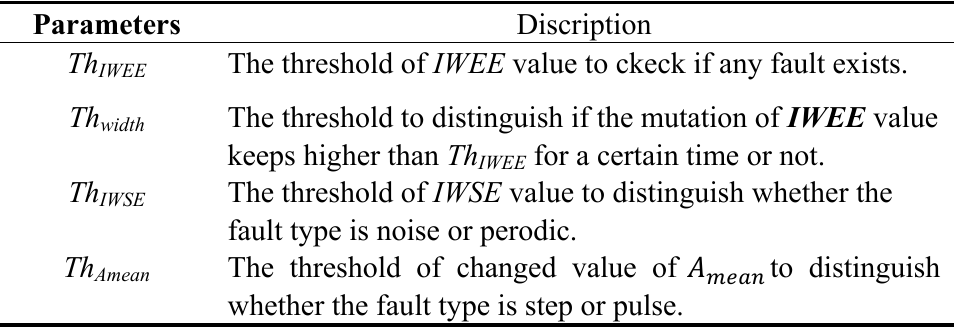
Table 1. Parameters for proposed method.